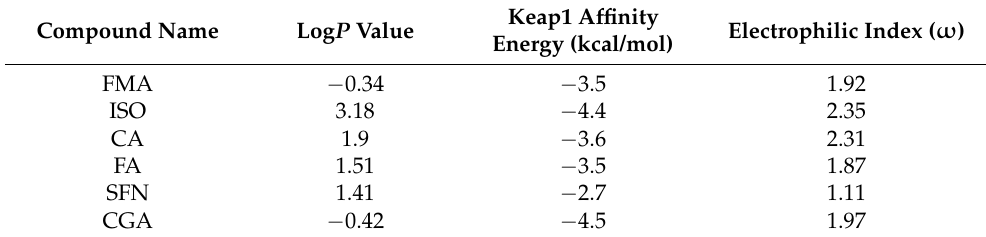
Table 2. Molecular characteristic values of